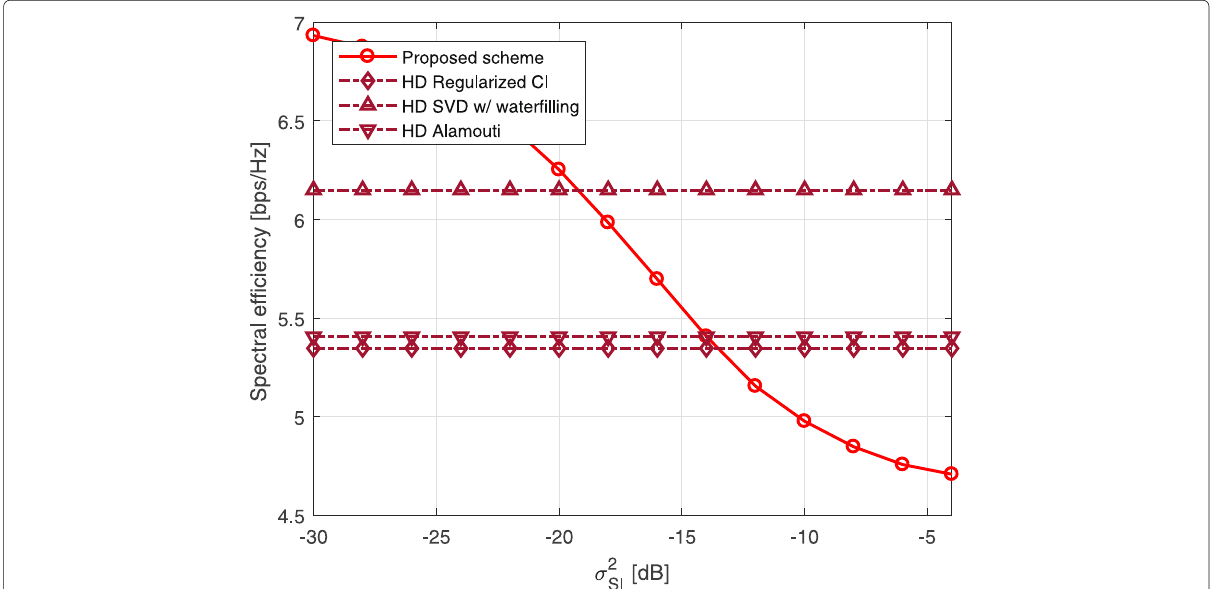
Fig. 6 The sum spectral efficiencies of the proposed scheme and the existing schemes according to residual self interference